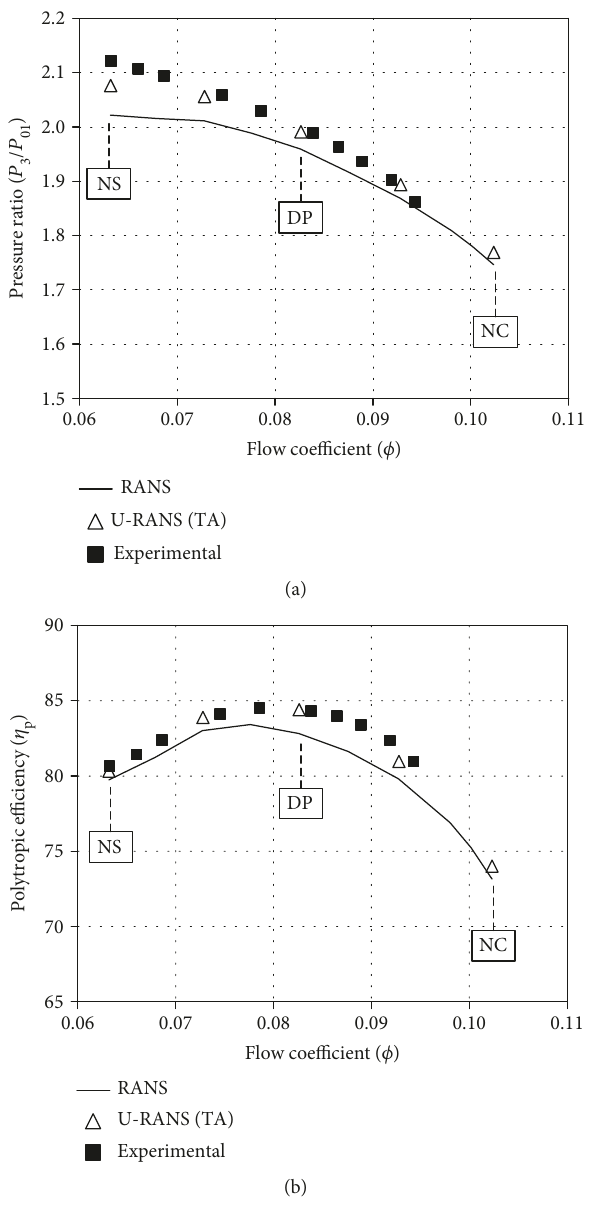
Figure 5: Compressor stage characteristics: (a) total-to-static pressure ratio and (b) polytropic e ffi